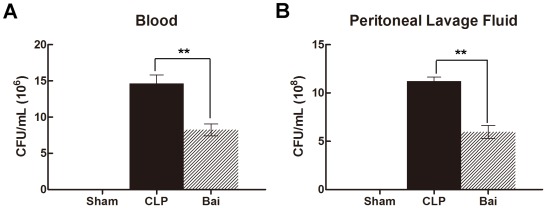
Bacterial clearance in blood (A) and peritoneum (B) in septic mice after baicalin treatment.Baicalin enhanced bacterial clearance in blood (A) and peritoneum (B). Blood and peritoneal lavage fluid were harvested 24 h after CLP. Bai, baicalin group; CLP, CLP group. Data analyses with one-way ANOVA and Newman-Keuls. ** P<0.01.